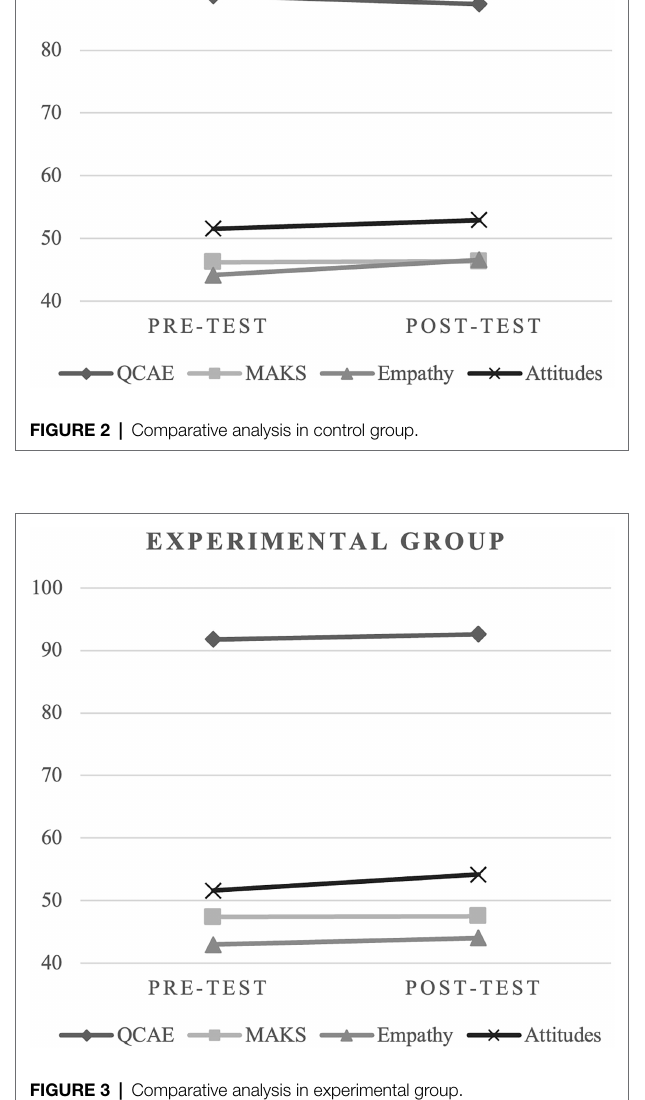
FIGURE 3 | Comparative analysis in experimental